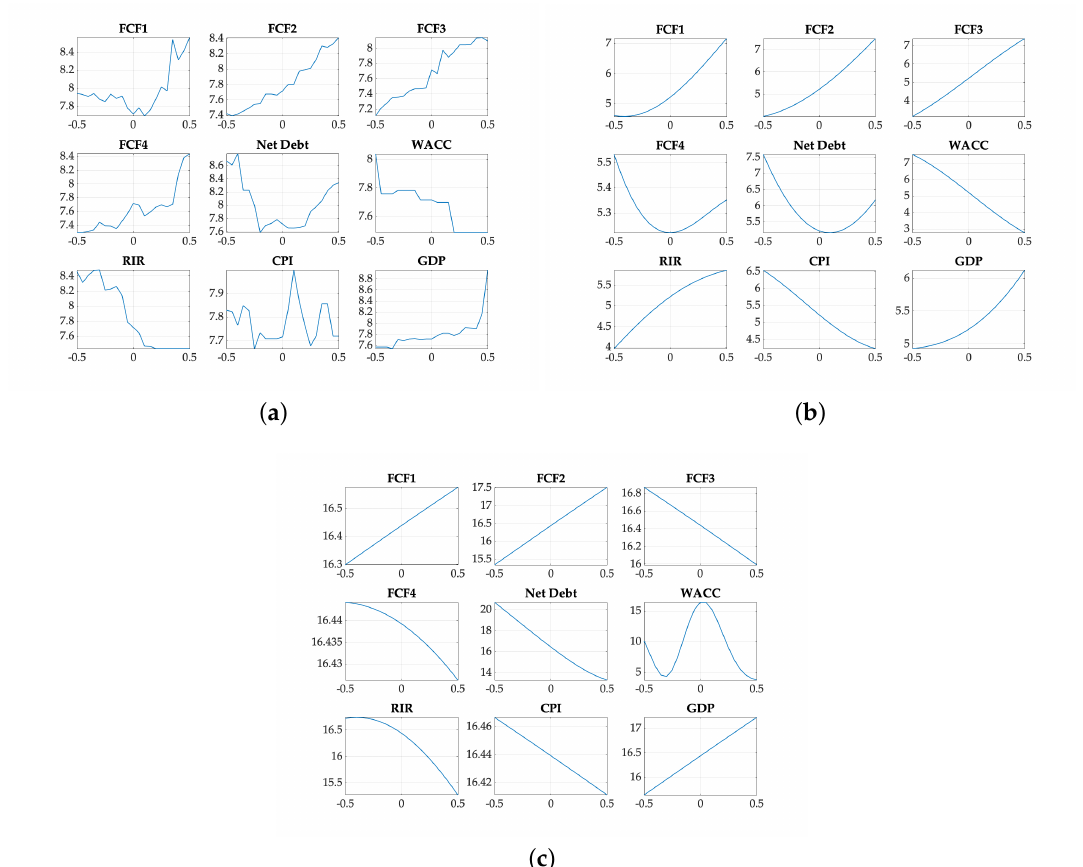
Figure 3. Trend analysis of significant variables for bagging trees ( a ), SVR ( b ), GPR and ( c